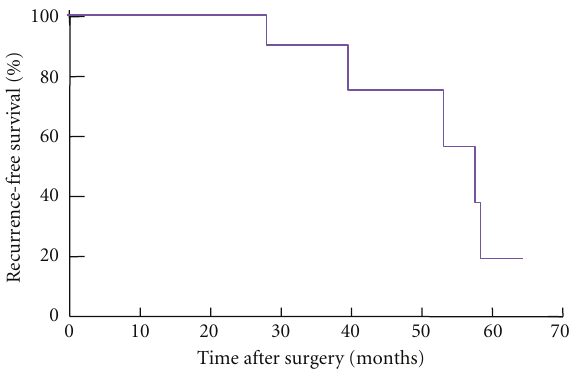
Figure 3: Recurrence-free survival after surgery with median F/U of 48 months ( n =